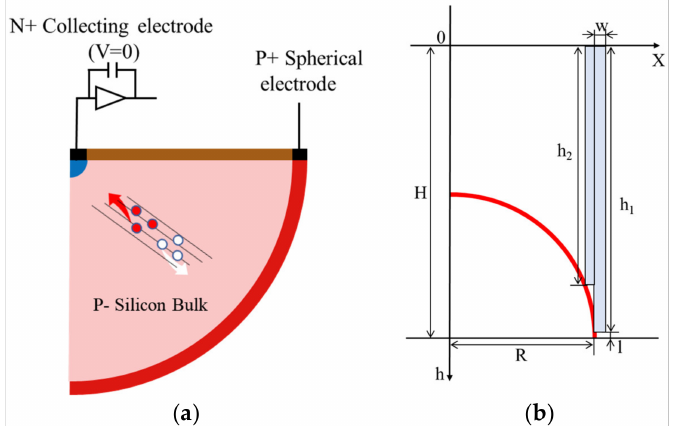
Figure 10. ( a ) 2D profile of the hemispherical electrode detector for process simulation; ( b ) The process simulation structure